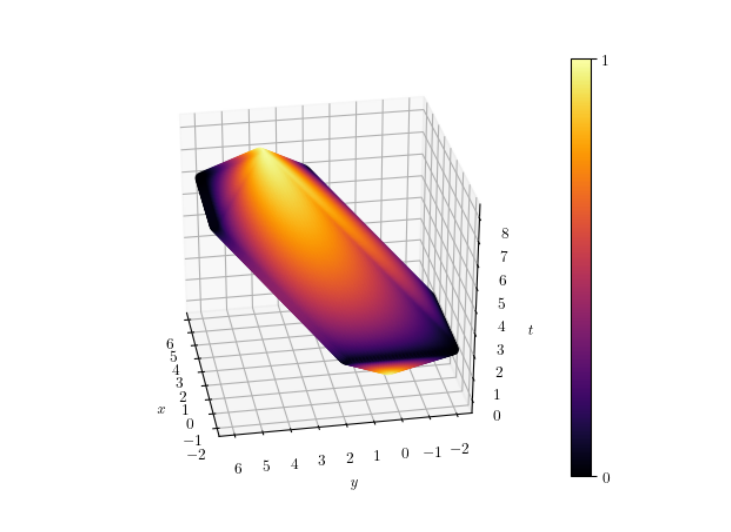
Figure 10. The barycentric-based visit probability for the pyramidal shaped prism with anchor points ( 0,0,0 ) and ( 4,4,8 ) , for v max = 1 and the number of levels (cid:96) being